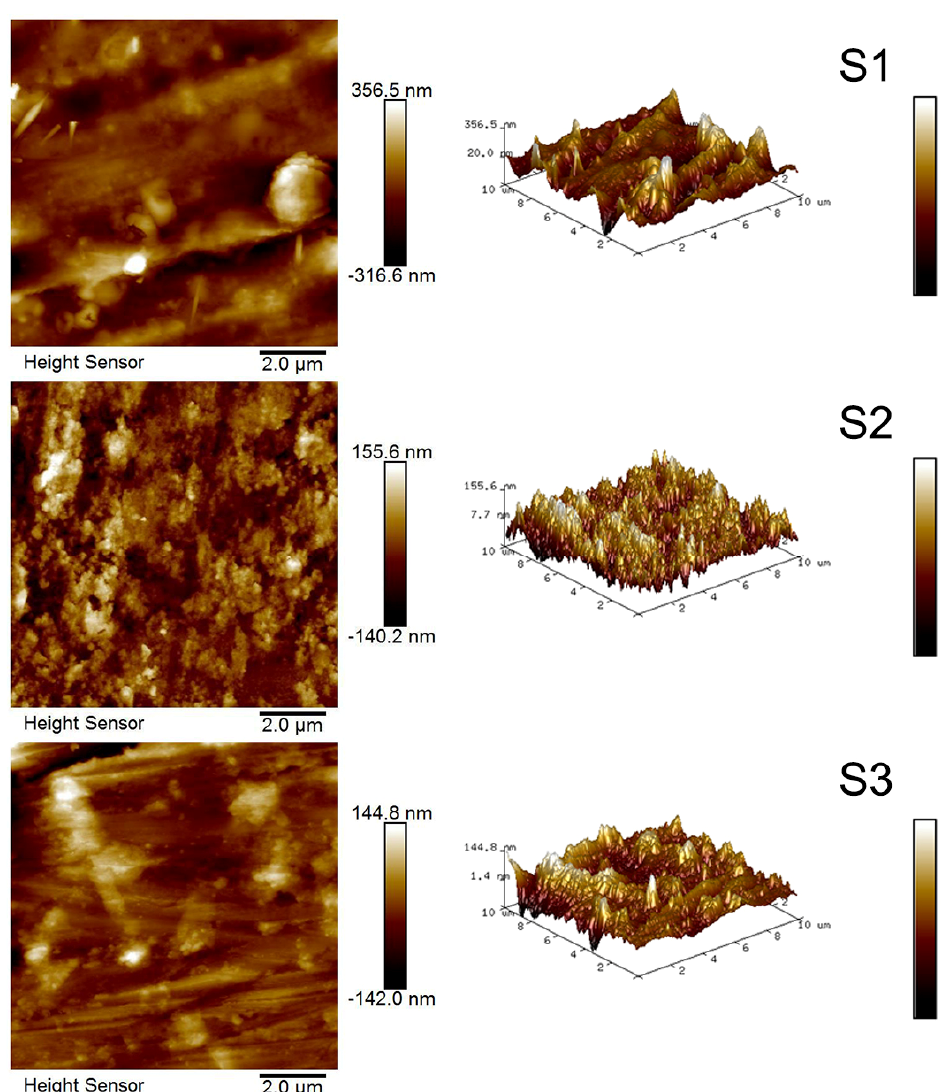
Figure 2. Three−dimensional AFM images of the samples: (S1) primal specimen, (S2) USRP speci- Figure 2. Three − dimensional AFM images of the samples: ( S1 ) primal specimen, ( S2 ) USRP speci- men, (S3) USRP + HELL specimen. men, ( S3 ) USRP + HELL Table 2. Roughness and microhardness information.